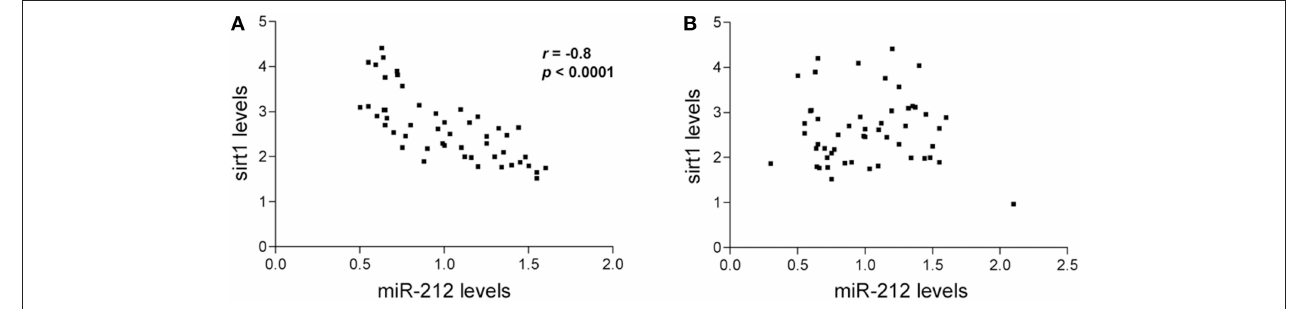
FIGURE 2 | Inverse relationship between miR-212 and sirt1 expression in the frontal cortex. Spearman rank correlations were performed to test for relationships between miR-212 and sirt1 expression. Scatterplots show that lower miR-212 transcript expression was associated with higher sirt1 transcript expression in (A) frontal cortex ( r = − 0.81, p < 0.0001 ), but not in (B) temporal cortex in the subjects examined.